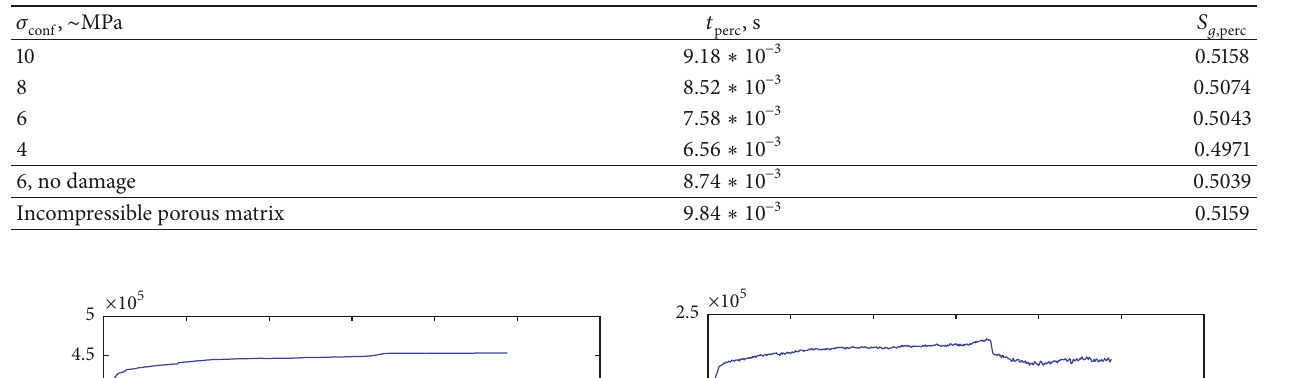
Table 5: Percolation times 𝑡